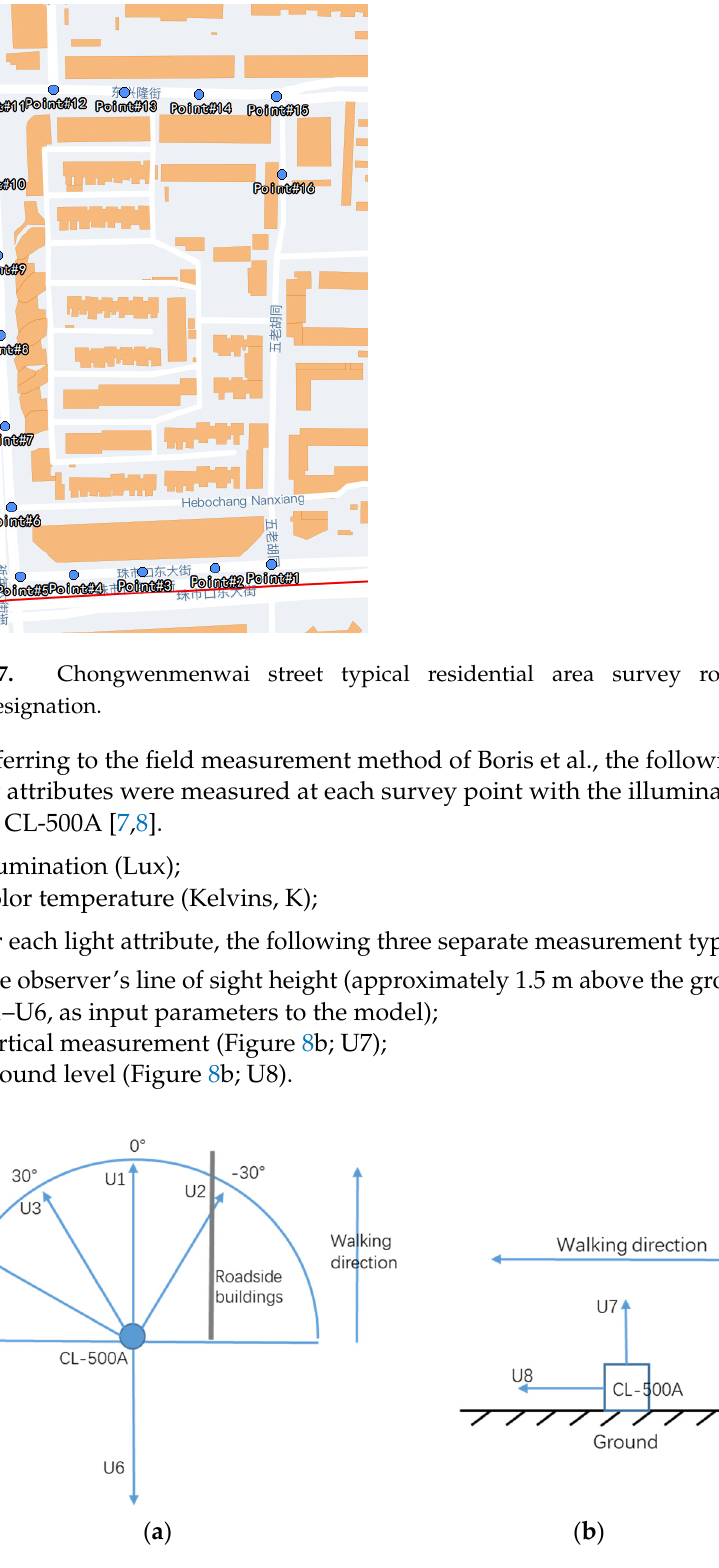
Figure 8. Field measurement method at each survey point. ( a ) The direction of measurement at the observer’s line of sight height; ( b ) Direction of measurement on the ground.